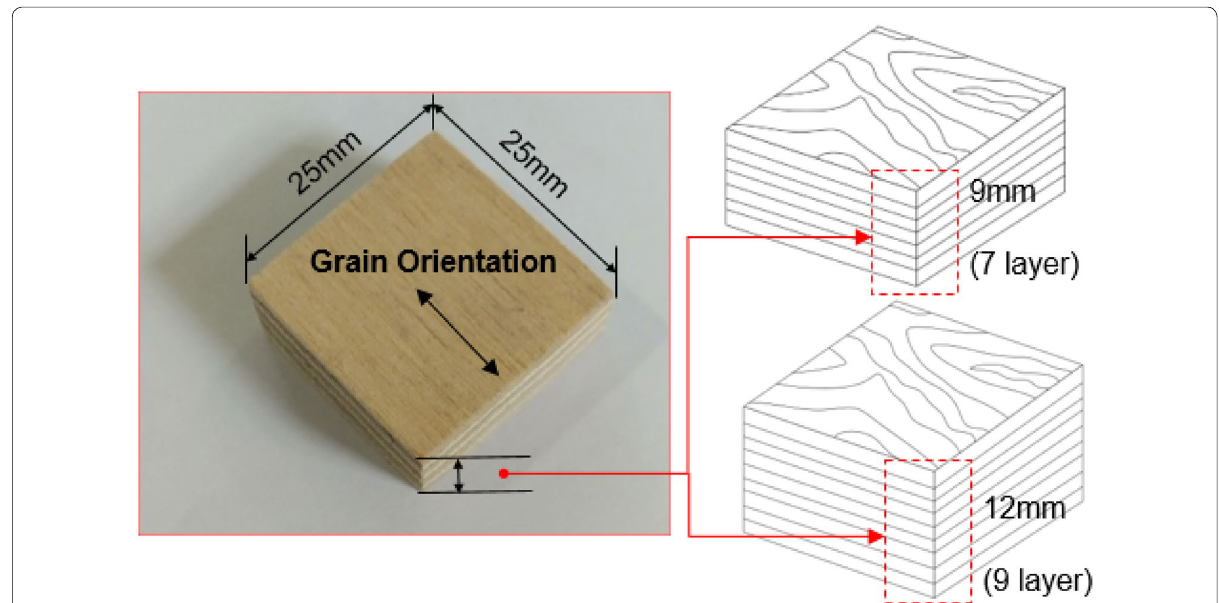
Fig. 4 Shape and dimensions of plywood test specimen